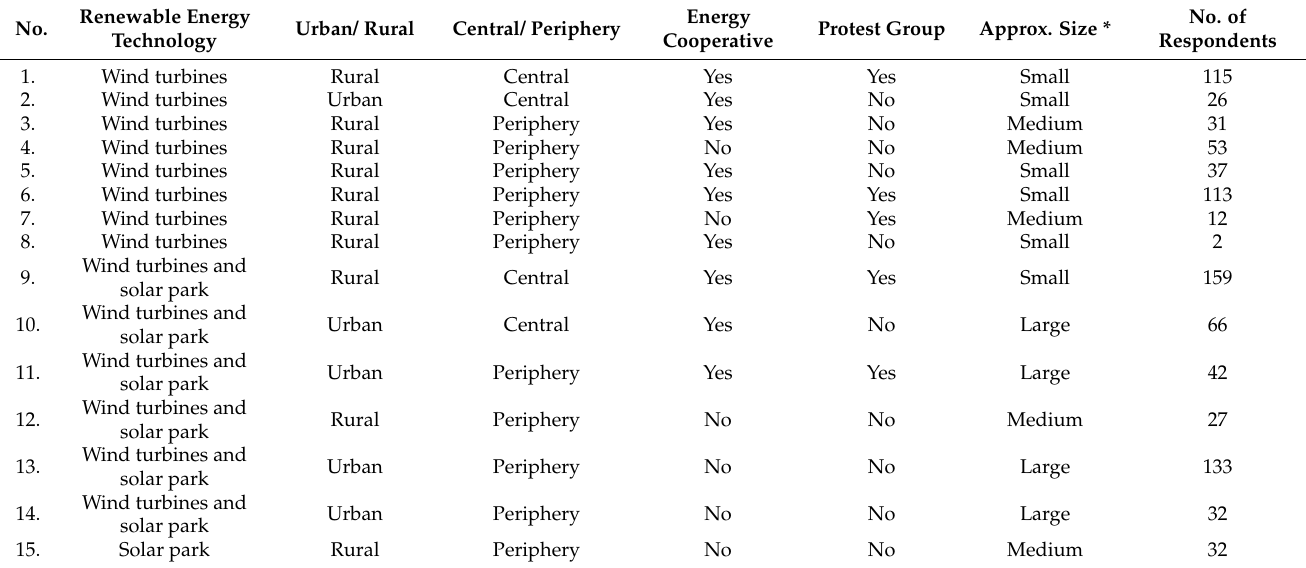
Table 1. Characteristics of the energy communities included in this